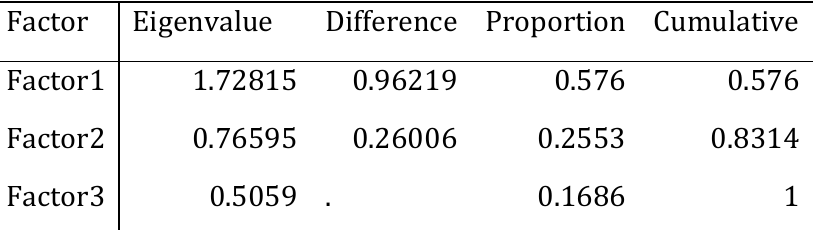
Fig. A1.5. Results of principal components